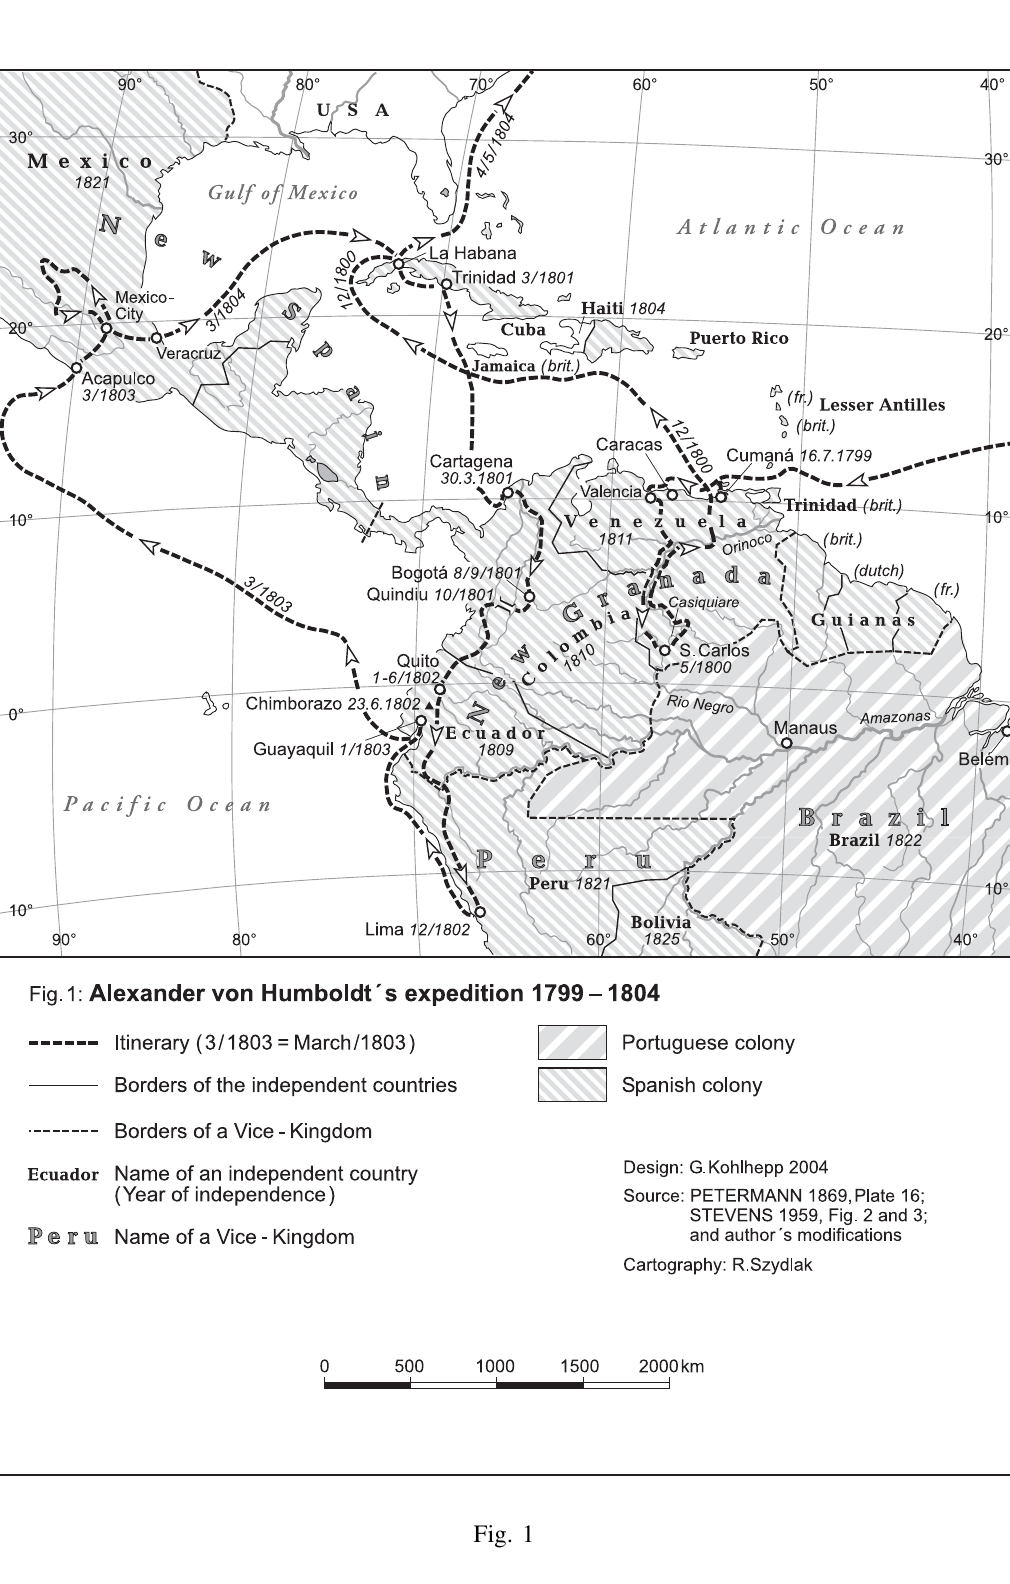
An Acad Bras Cienc (2005) 77